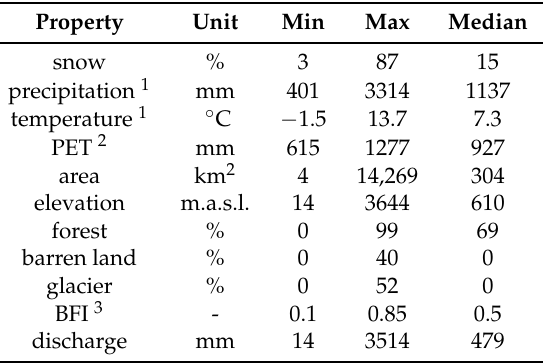
Table 1. Characterization of the considered